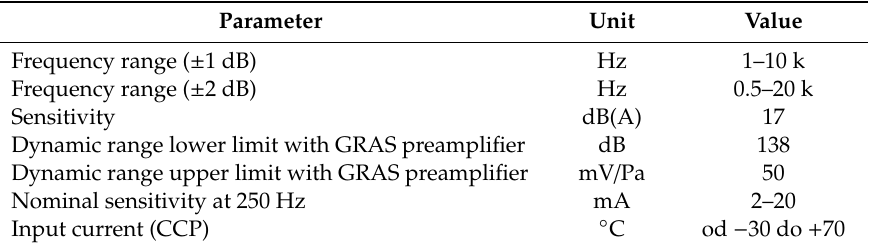
Table 1. Summary of basic parameters of GRAS 46AZ microphone.